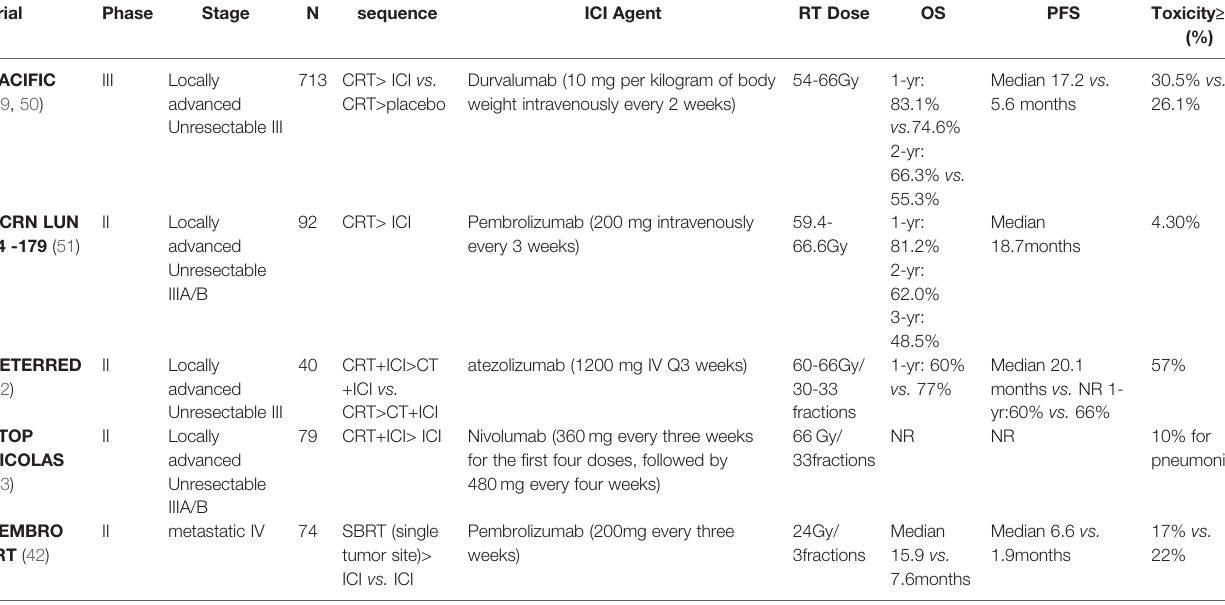
TABLE 1 | Prospective clinical trials evaluating PD-1/PD-L1 blockades combining with RT in NSCLC.